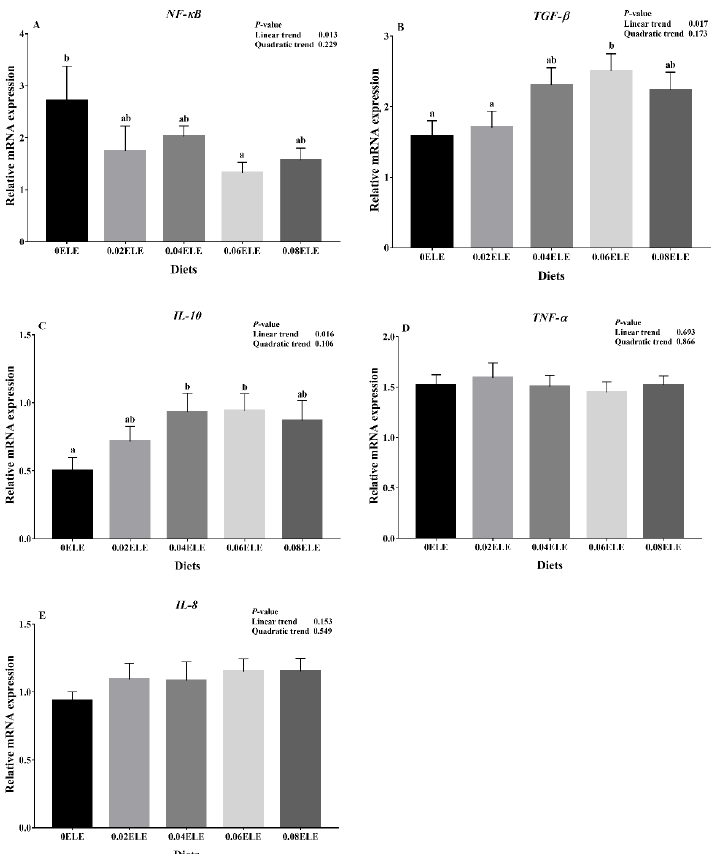
Figure 4 . Relative expressions of NF- κB signaling pathway with different ELE levels. NF- κB ( A ); TGF- β ( B ); IL-10 ( C ); TNF- α ( D ); IL-8 ( E ). Data are expressed as means ± S.E.M., value with different letters (a, b) are significantly different ( p < 0.05).